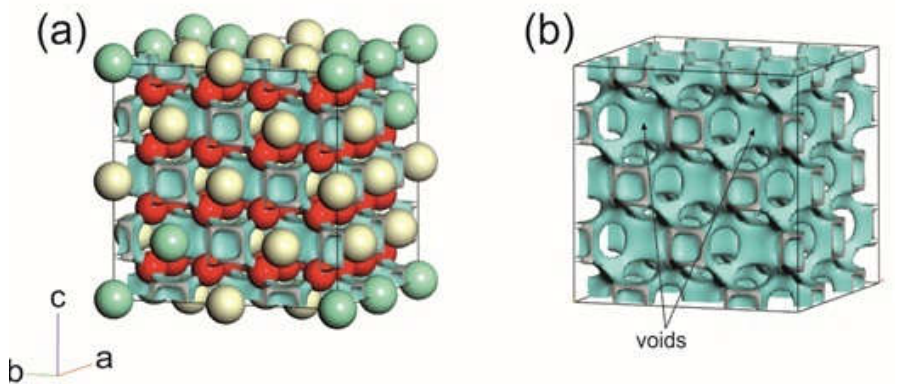
Figure 9. Oxygen-ion migration pathways obtained by BVS (Δ BVS = 0.3) for Ce 0.8 Sm 0.2 O 1.9 (turquoise clouds) with ( a ) and without ( b ) crystal structure of Ce 0.8 Sm 0.2 O 1.9 .